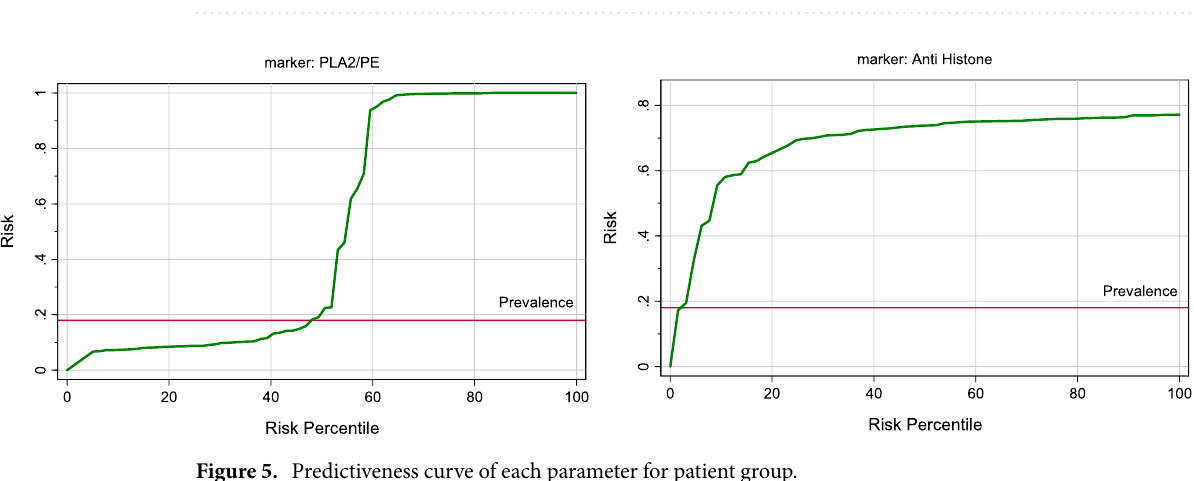
Figure 4. ROC curve of PLA2/PE and anti histone in patient group.